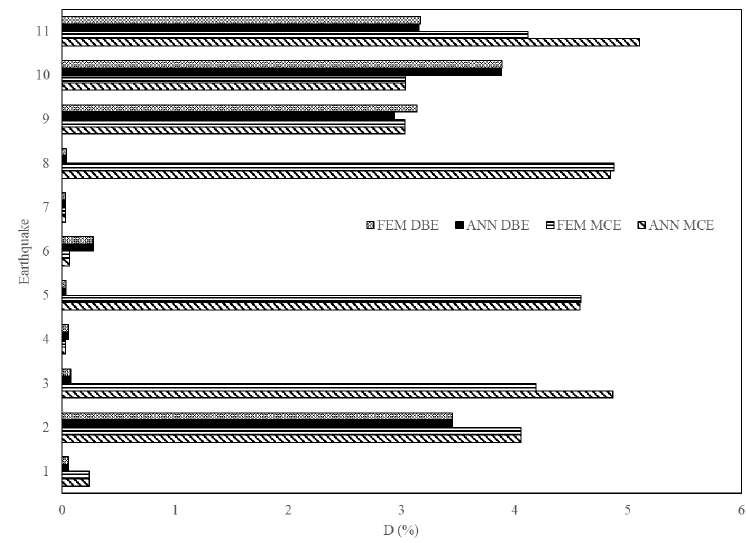
Figure 19. MIDR of a three-story mass irregularity structure obtained from ANN and NLTHA considering DBE and MCE levels.